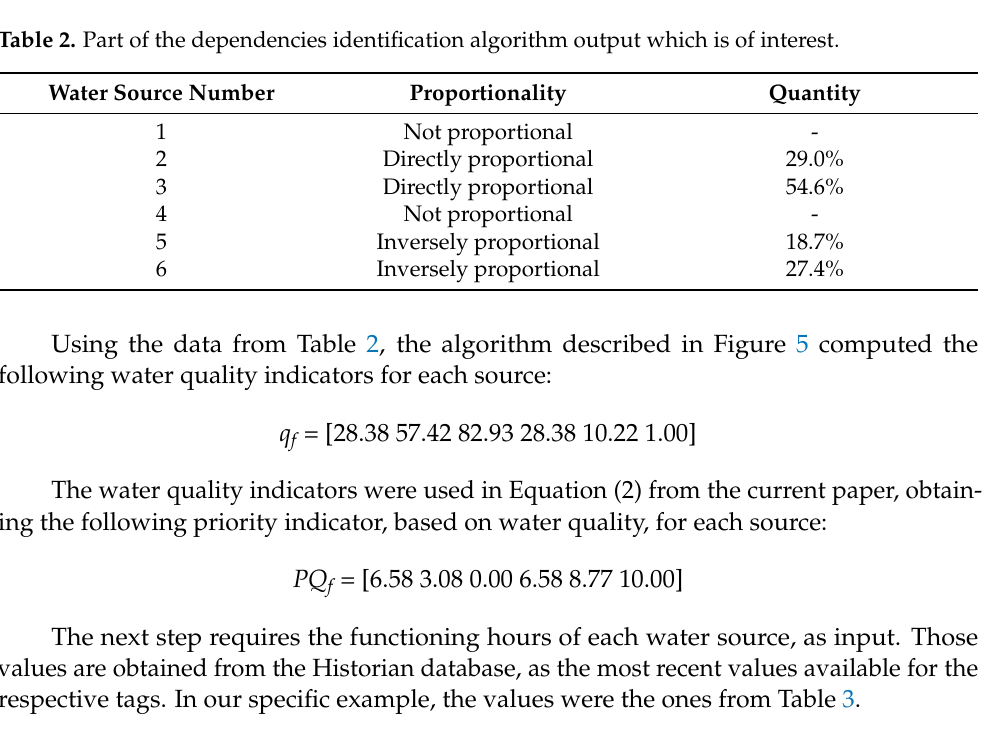
Table 3. The most recently recorded functioning hours for the water sources, at the time of optimization. Water Source